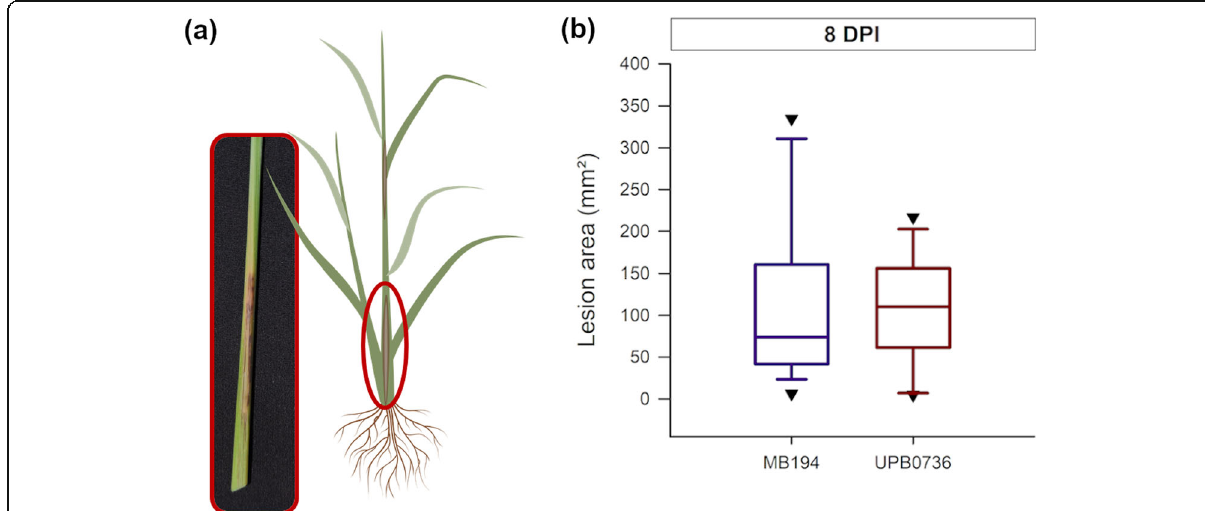
Fig. 4 Virulence of Pseudomonas fuscovaginae wild type strains on Kitaake rice plants. When 7 weeks old, rice plants were inoculated with P. fuscovaginae. ( a ) Lesions on the rice sheath at 8 days post inoculation (DPI). Rice plants were inoculated with bacterial solution and scored at 8 DPI ( b ). The purple boxplot represents strain MB194 and the red boxplot represents UPB0736. All boxplots show the median with the first and third quartile, the whiskers show the minimum and maximum values. Outliers and extreme values are represented by triangles. The lesions did not differ significantly (Wilcoxon rank sum test, n = 25, α =